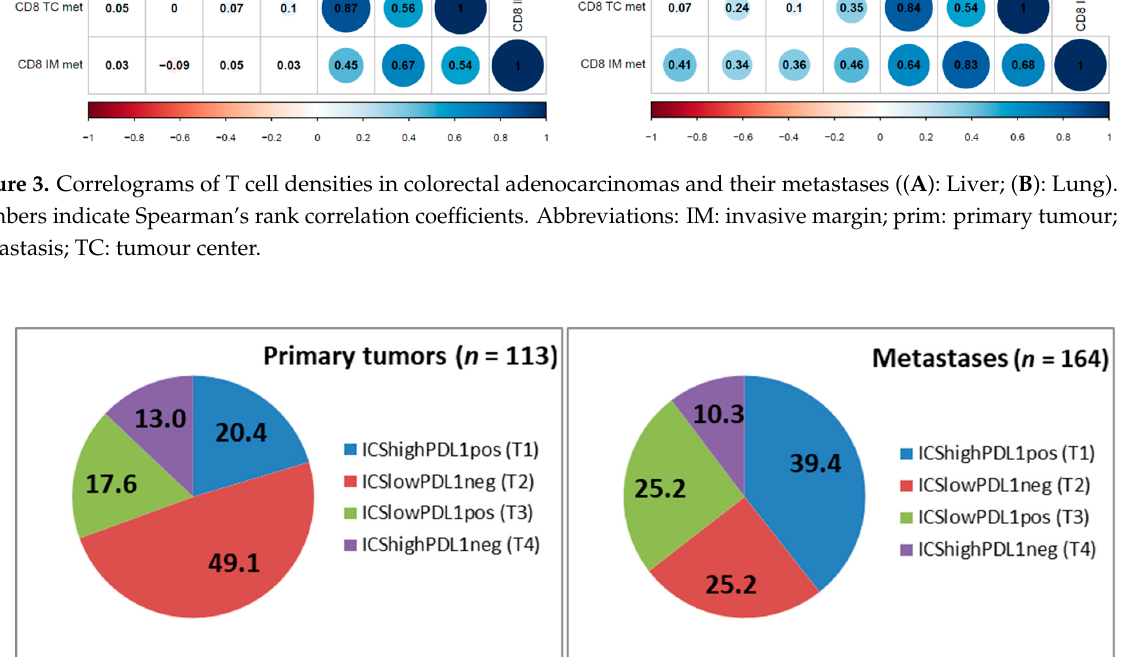
Figure 3. Correlograms of T cell densities in colorectal adenocarcinomas and their metastases (( A ): Liver; ( B ): Lung). The numbers indicate Spearman’s rank correlation coefficients. Abbreviations: IM: invasive margin; prim: primary tumour; met: metastasis; TC: tumour center.